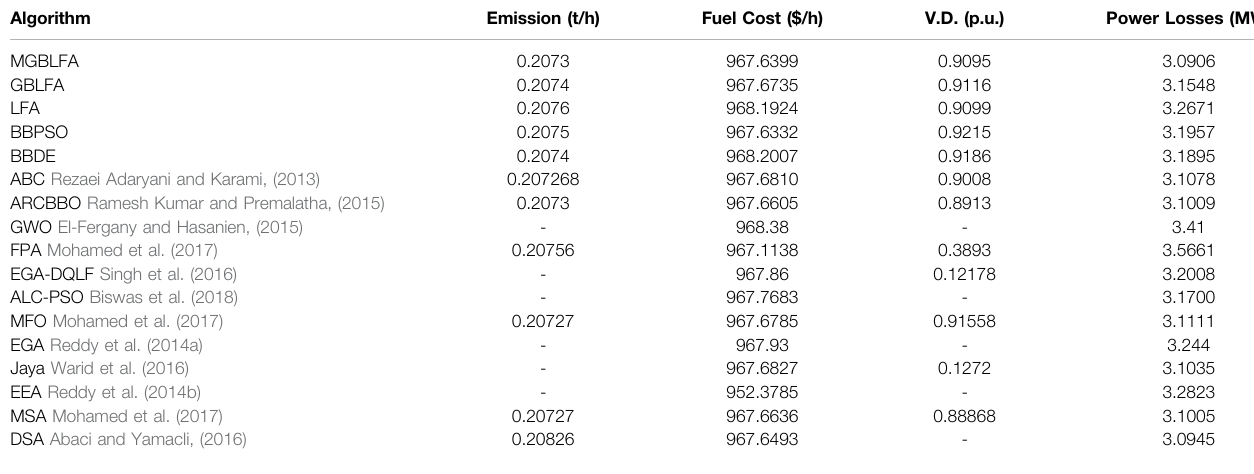
TABLE 5 | Comparison of optimal results by algorithms for Case 4.